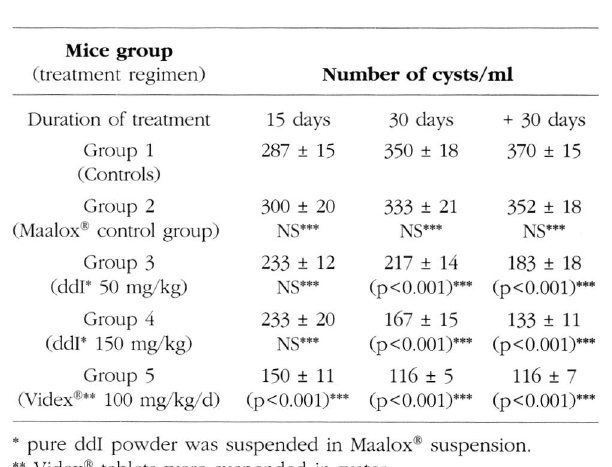
Table 1. - Number of mice cerebral cysts per ml (± standard devia tion) after 2',3'-dideoxyinosine treatment per os of 15 days, 30 days and 30 days after the last dose of the 30 days